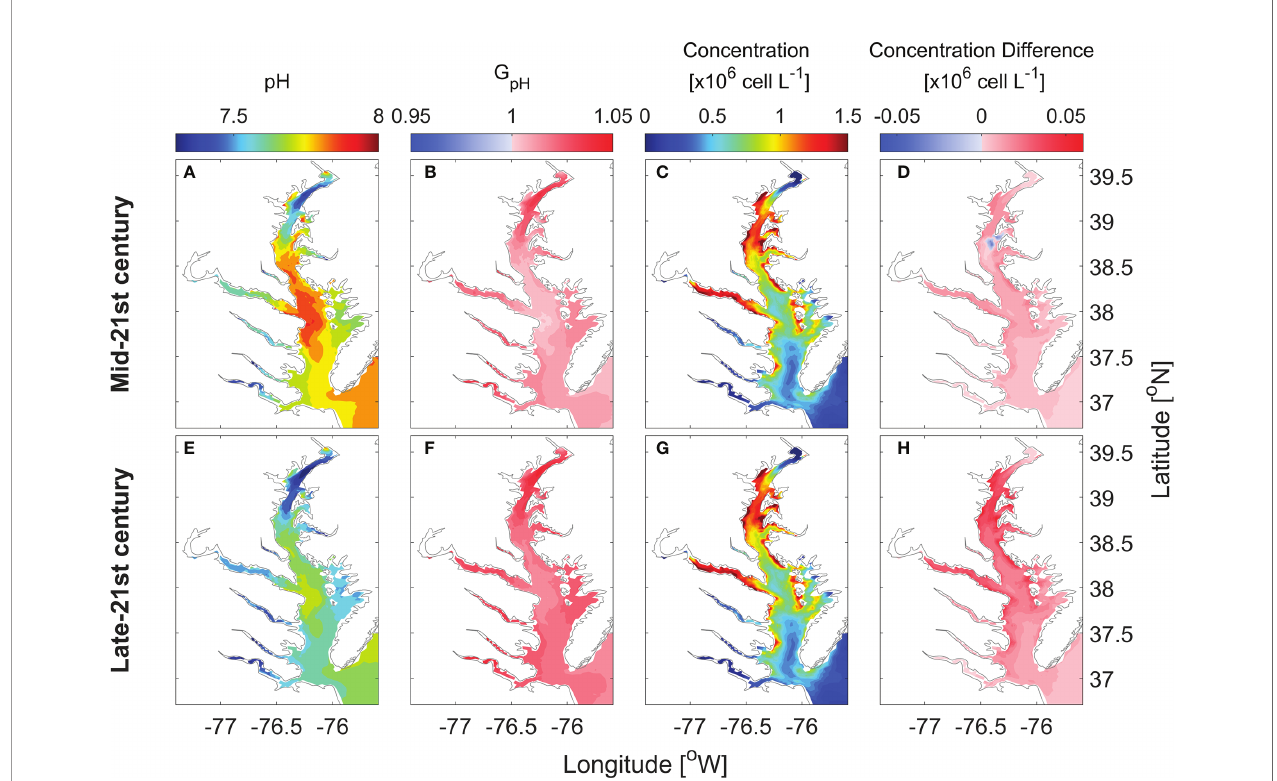
FIGURE 8 | Horizontal distribution of monthly-mean surface pH (A, E) , G pH (B, F) , P. minimum cell concentration (C, G) , and the concentration difference between model results of future projection and year 2006 (D, H) in May.